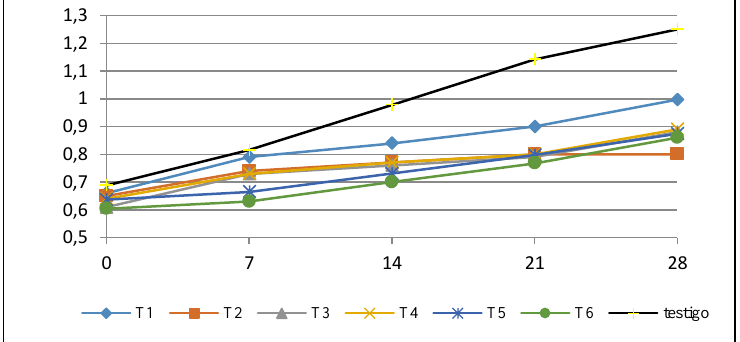
Figure 2: Behavior of exudation during the evaluation